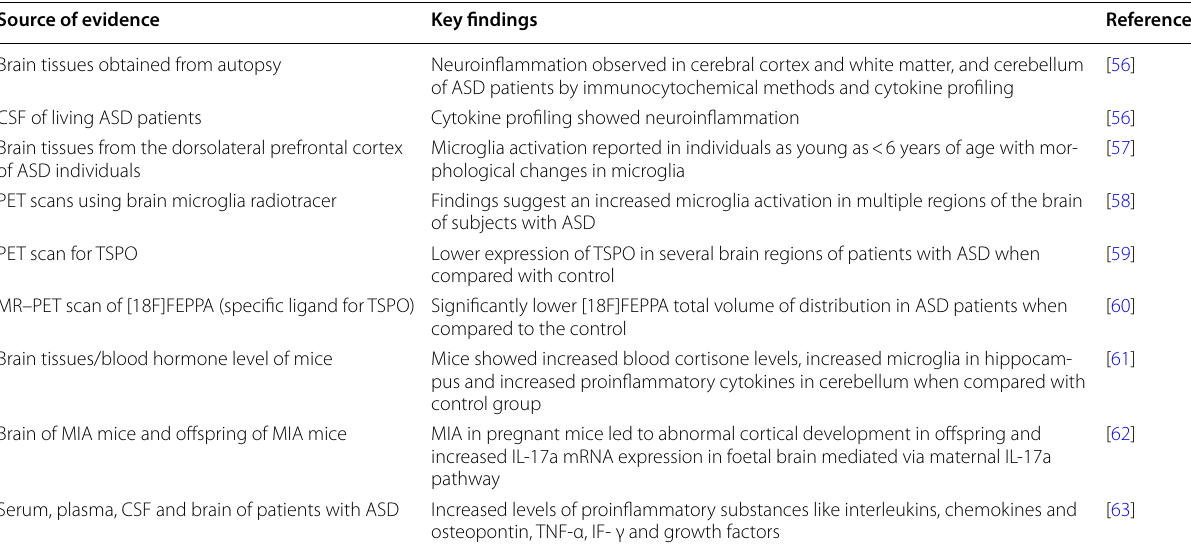
ASD autism spectrum disorders, CSF cerebrospinal fluid, IF interferon, IL interleukin, MIA maternal immune activation, MR magnetic resonance, PET positron emission tomography, TNF-α tumour necrosis factor-α, TSPO translocator protein